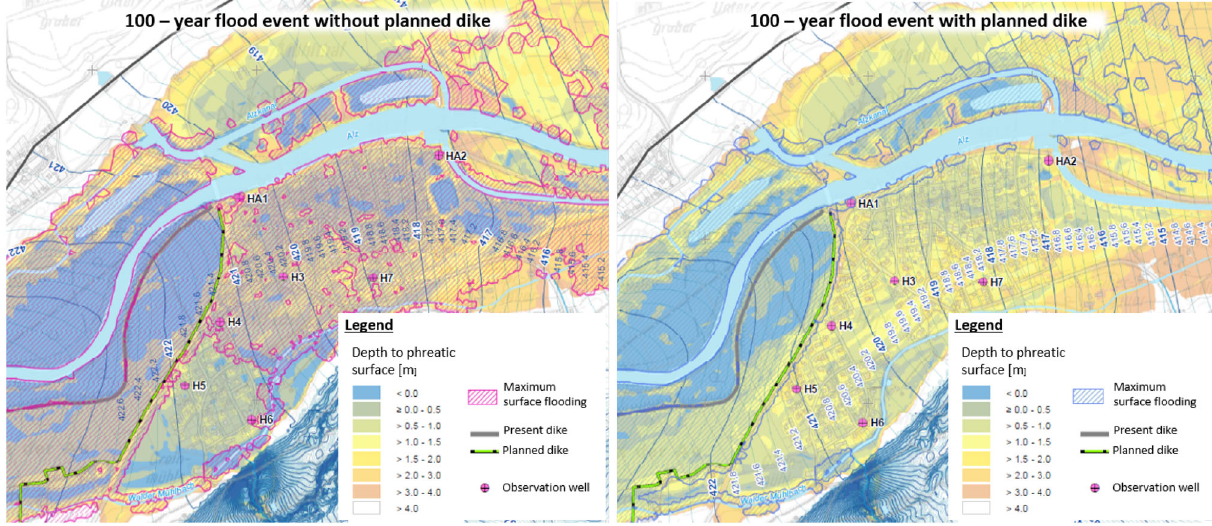
Fig. 10 Modeled groundwater levels for a 100-year event. Left: groundwater level and flooding without planned dike. Right: groundwater level and flooding with planed